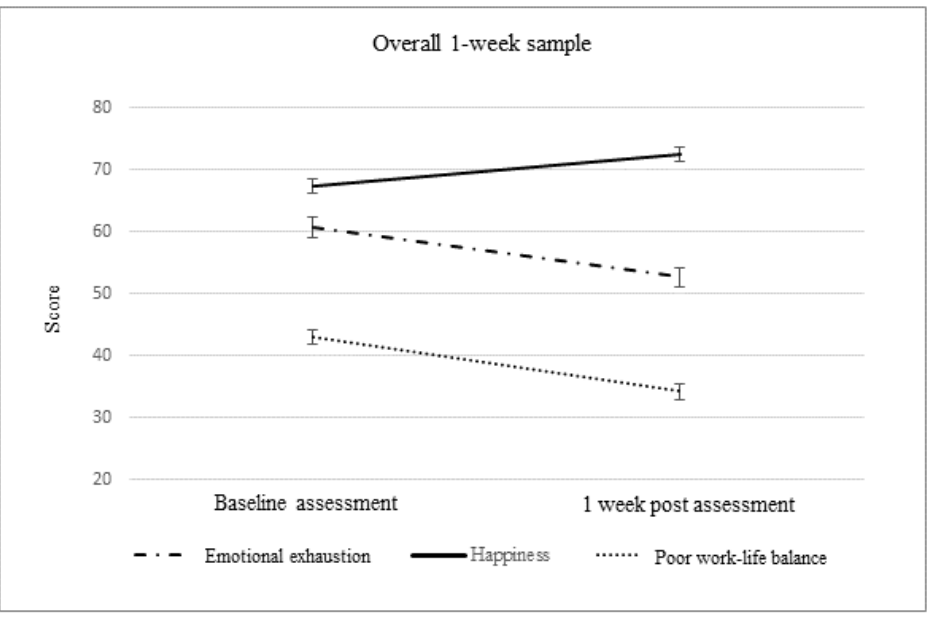
Figure 1. Pre- and postintervention well-being scores. For demonstration purposes, the work-life balance variable was scaled 0-100 in this graph, original response range 1-4. Error bars represent SE means.